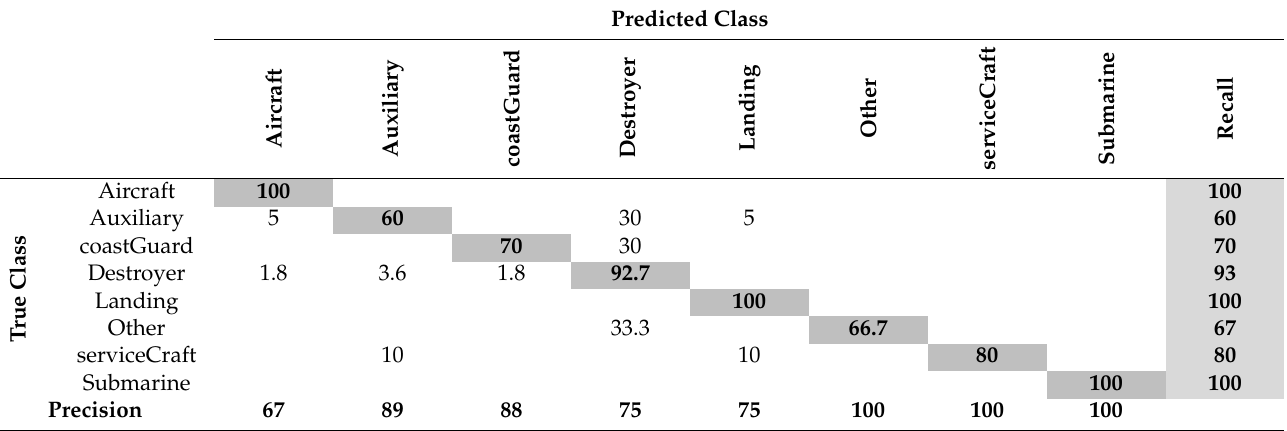
Table 10. The confusion matrix of the identification stage (values in percentage). Predicted